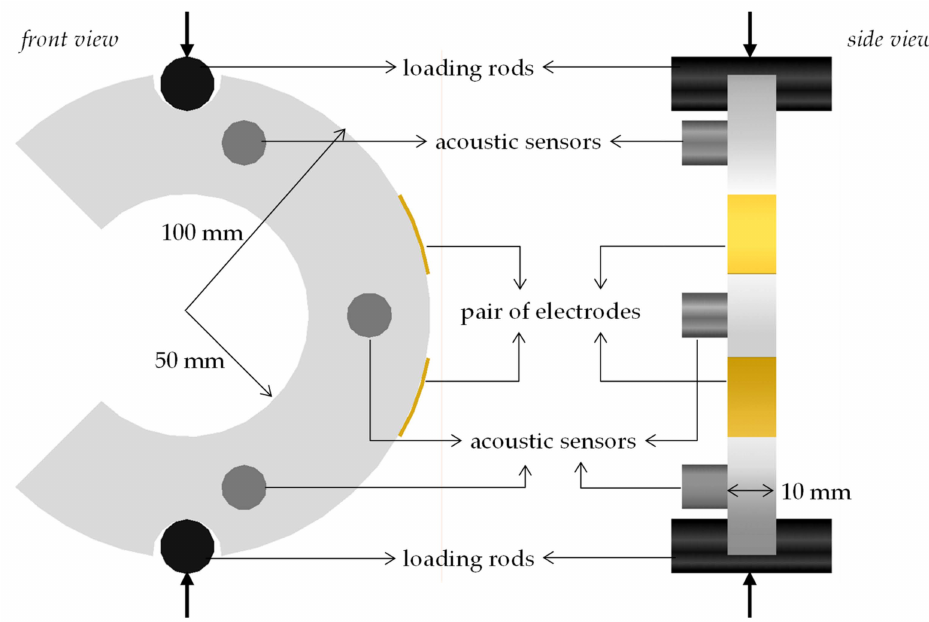
Figure 10. The geometry and the dimensions of the circular semi-ring (CSR) specimens.